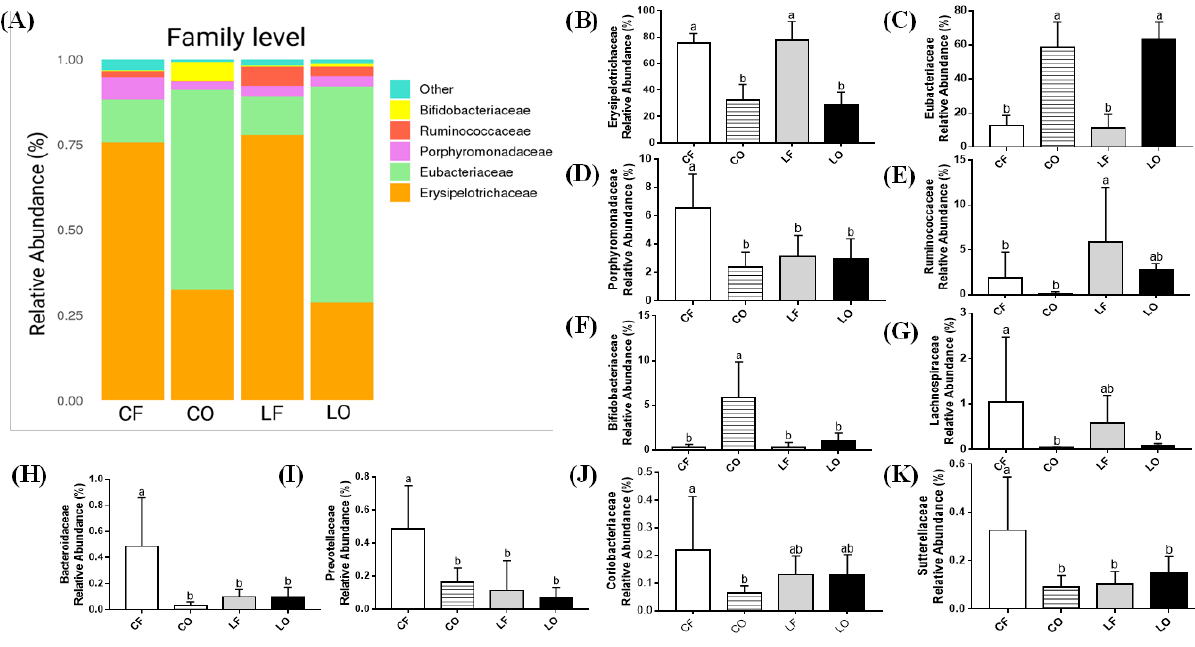
Figure 8. Family-level changes in bacterial composition of hamsters fed one of the four diets: CF, fresh corn oil; CO, oxidized corn oil; LF, fresh lard; LO, oxidized lard. ( A ) Bar plot of relative abundance (%). Comparison in abundances of: ( B ) Erysipelotrichaceae, ( C ) Eubacteriaceae, ( D ) Porphyromonadaceae, ( E ) Ruminococcaceae, ( F ) Bifidobacteriaceae, ( G ) Lachnospiraceae, ( H ) Bacteroidaceae, ( I ) Prevotellaceae, ( J ) Coriobacteriaceae, and ( K ) Sutterellaceae. Data are expressed as mean ± S.D., where different letters indicate statistical difference, p < 0.05.